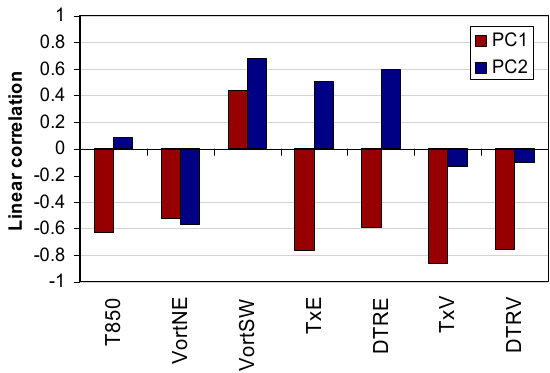
Figure 3. Correlations of the variables with PC1 and PC2 (daily data 1948–2006).